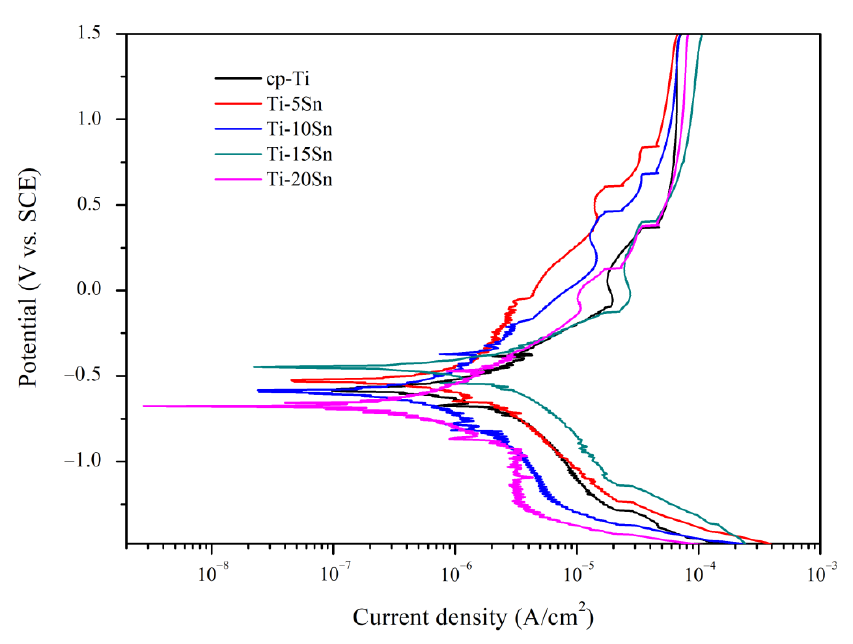
S and s are abbreviations for Siemens and second, respectively. Rs, R, CPE, and n represent solution resistance, resistance of passive layers, constant phase element, and bode plot slope (|Z| vs. frequency), respectively. Standard deviations are in the parentheses.